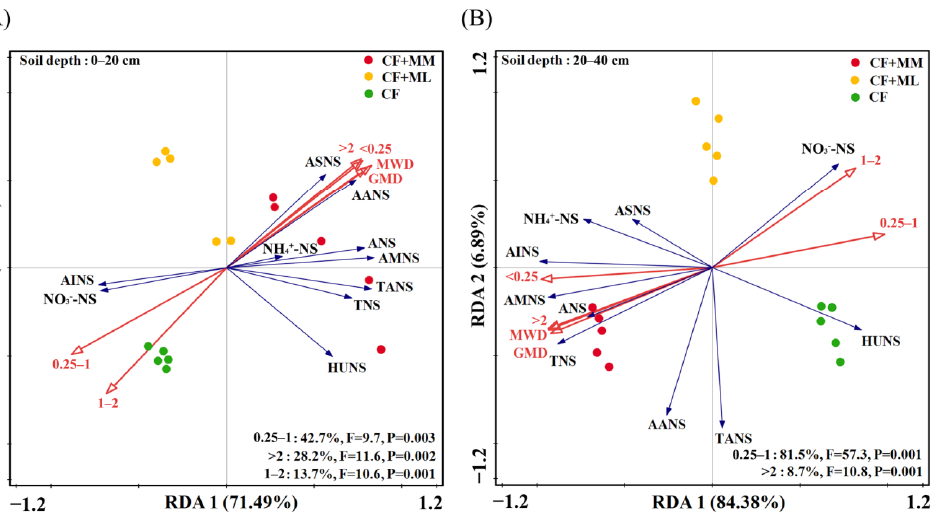
Figure 7. Redundancy analysis of soil nitrogen stock and environmental factors in Chinese fir plan- tations with different stand types in 0 – 20 cm ( A ) and 20 – 40 cm ( B ) soil depth. TNS, ANS, NO 3 − -NS,